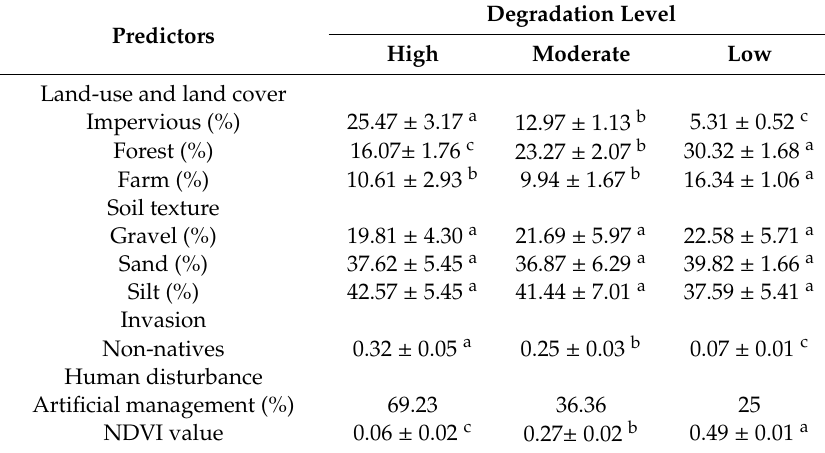
Table 5. Environmental variables in three groups of degradation level. Values represent means ± SE. Values that share the same letter are not significantly di ff erent at 0.05 significance level. Notes: forest, proportion of forest cover in a 500-m bu ff er zone; impervious, proportion of impervious surface in a 500-m bu ff er zone, farm, proportion of farmland in a 500-m bu ff er zone; gravel, percentage of gravel content; sand, percentage of sand content; silt; percentage of silt content; non-natives, the dominance of non-native species (range from 0 to 1); artificial management, presence of reinforced riverbank in the vicinity. NDVI value, mean NDVI value in a 500-m bu ff er zone (range from − 1 to